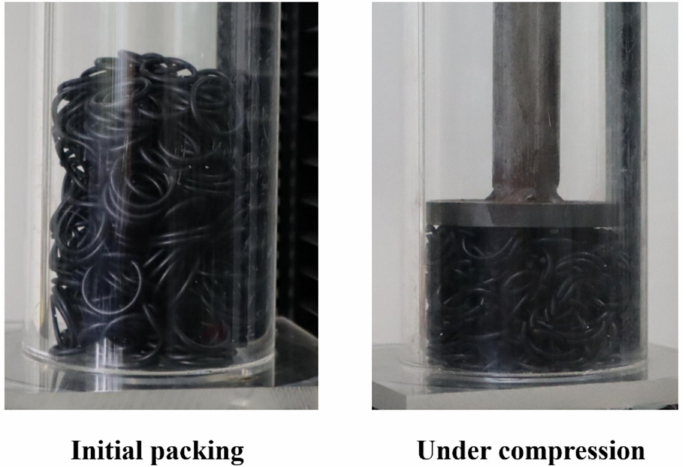
Figure 2. Experimental observations of the packing of flexible rubber rings subject to